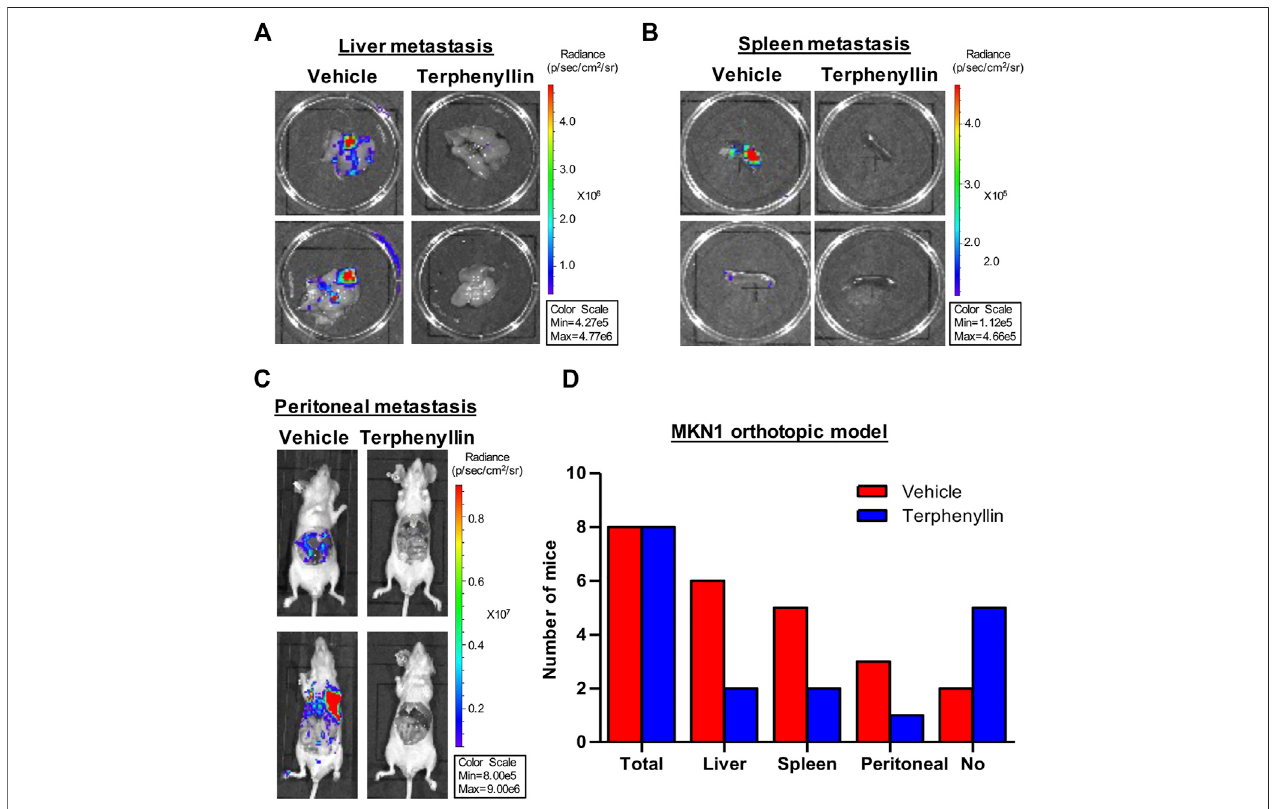
FIGURE 6 | Terphenyllin inhibits gastric cancer metastasis in vivo . (A,B) At the end of the experiment of the MKN1 model, the liver and spleen were removed from mice and imaged to detect metastatic lesions. (C) The peritoneal cavity of mice was imaged to detect peritoneal metastasis. (D) The number of mice with liver, spleen, and peritoneal metastasis in the vehicle group and terphenyllin treated group was counted respectively.